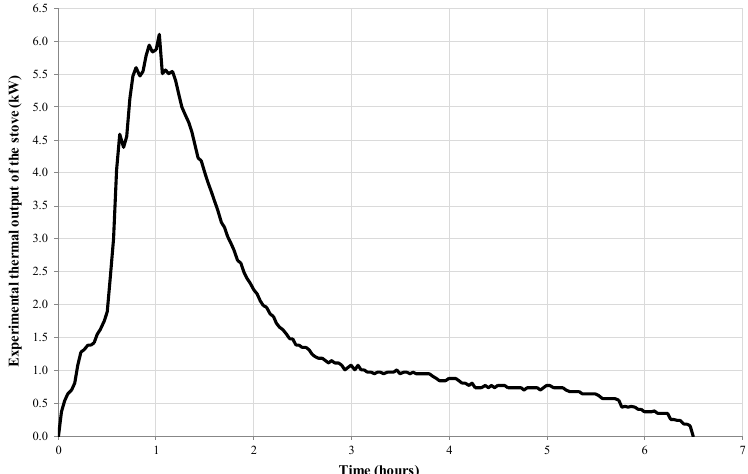
Figure 6. Experimental thermal output of the stove as a function of the time.